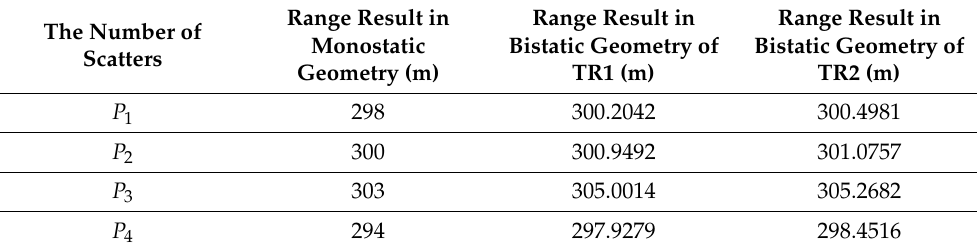
Table 1. The range result in different